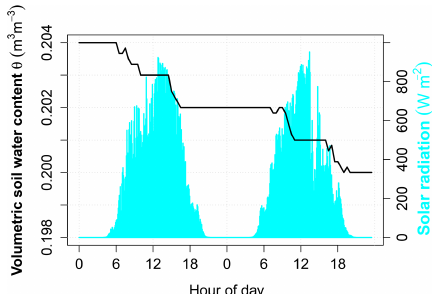
Figure A1. Observed diurnal decline in soil moisture over two sunny days in summer 2013 to illustrate the approach to estimate daily root water uptake from diurnal soil moisture variations. E RWU is estimated at sensor level per day as a cumulative sum of differ- ences from sunrise to sunset, in the absence of any nighttime varia- tions or daytime increases in soil